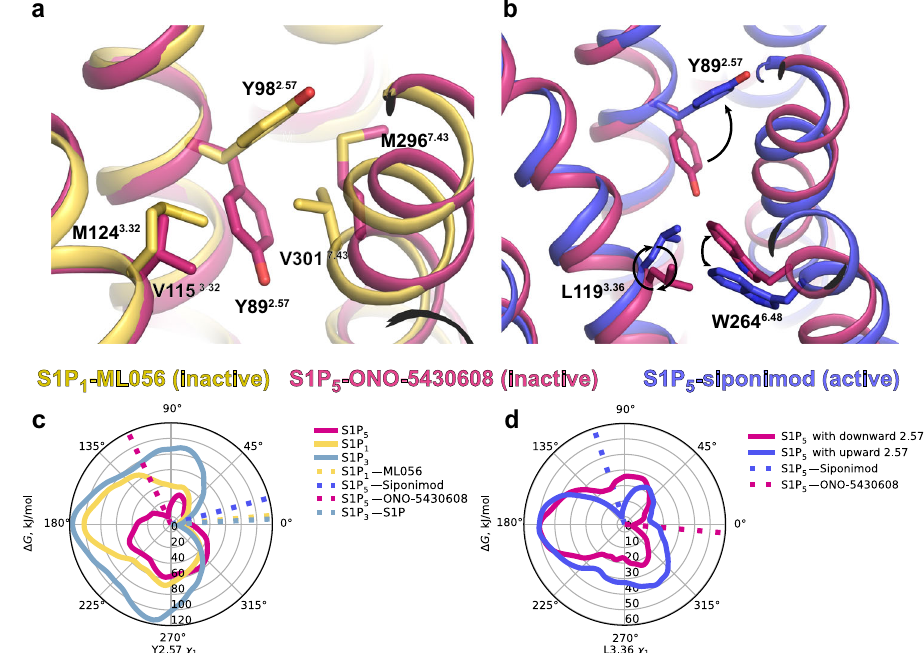
Fig.3|Conformational fl exibilityofY 2.57 anditseffectoninverseagonisminS1P receptors. a Two distinct upward and downward conformations of Y 2.57 as observedincrystalstructuresofS1P 1 -ML056(PDBID3V2Y)andS1P 5 -ONO-5430608 (this work, PDB ID 7YXA), respectively. b The downward orientation of Y 2.57 is incompatiblewiththe active stateofthe dualtoggle switchL 3.36 — W 6.48 because of a stericclash.S1P 5 -ONO-5430608(thiswork,PDBID7YXA,inactivestate)isshownin pink, and S1P 5 -siponimod (PDB ID 7EW1, active state) is shown in purple. c Free